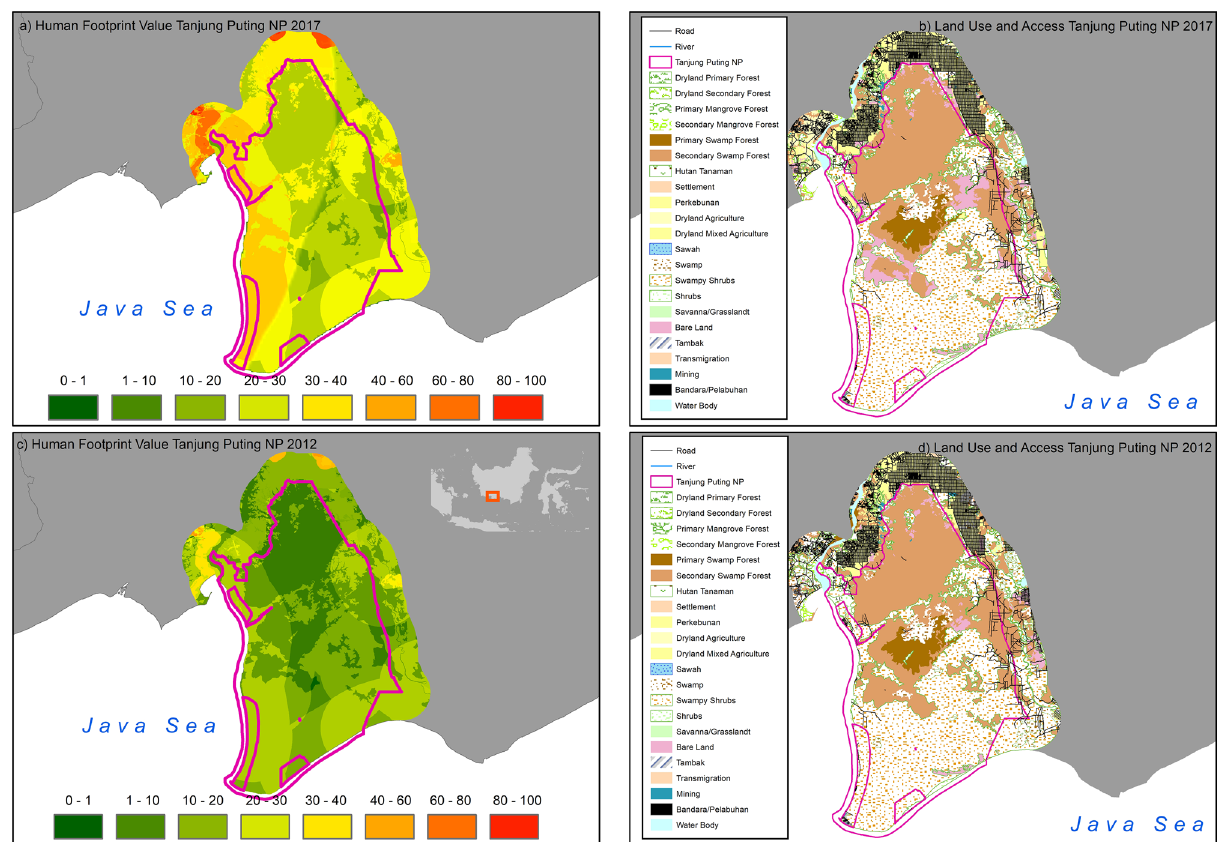
Figure 5. Human Footprint and land use in Tanjung Puting National Park, Kalimantan in 2012 and 2017. Activity data maps of Tanjung Puting NP (land cover maps, roads, river and settlements of respected years) used ://www.prote ctedp lanet .net/en). The Maps were created using Esri ArcMap 10.8 (https ://www.arcgi